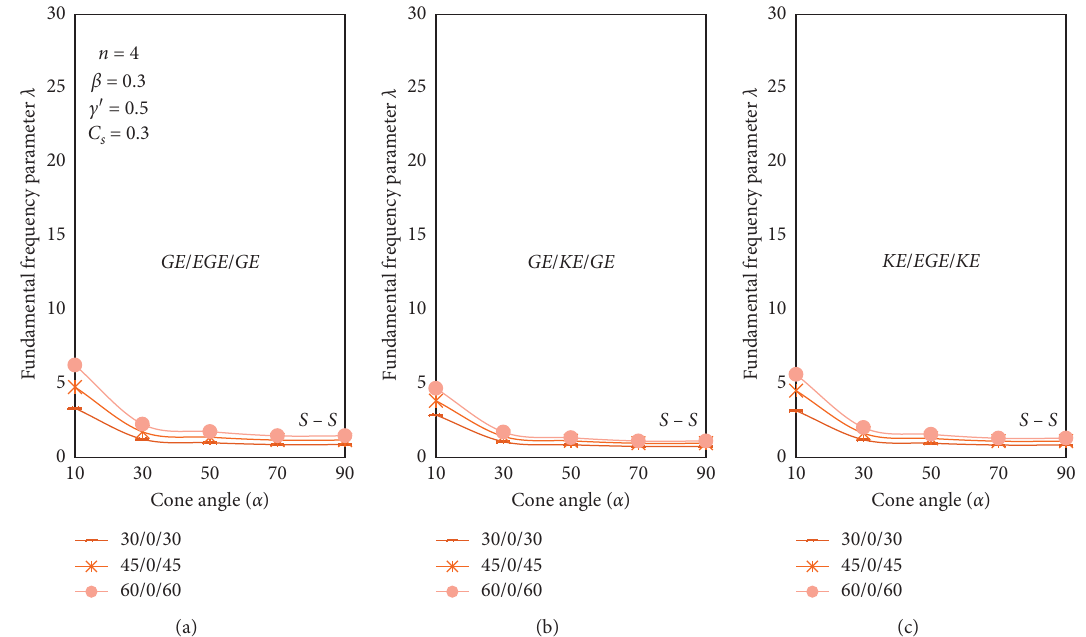
Figure 6: Influence of cone angle on the fundamental frequency parameter of three-layered conical shells with different material combinations.